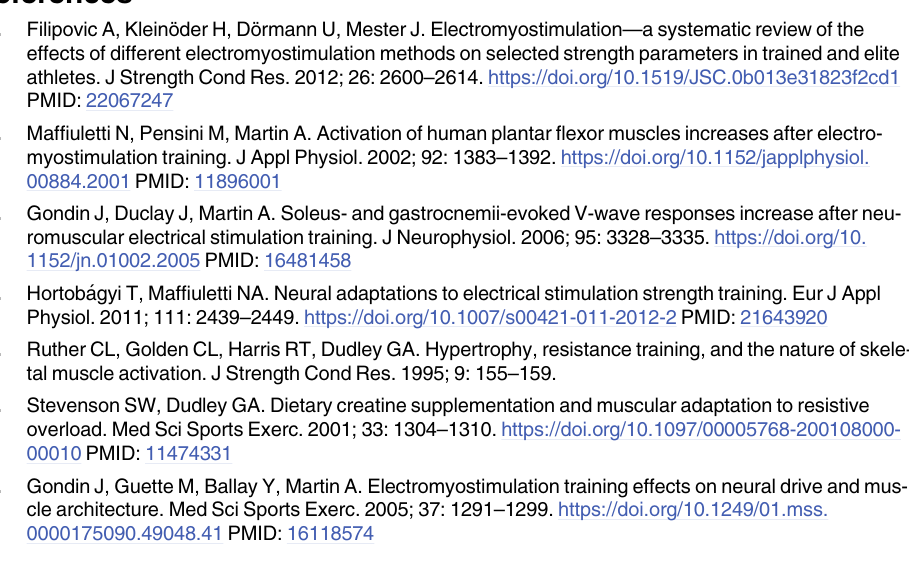
S1 Table. Abdominal muscle cross-sectional area, fat thickness, and body mass of each par- ticipant before and after the intervention period. RA, rectus abdominis; CSA, cross-sectional area; AO, abdominal oblique muscles